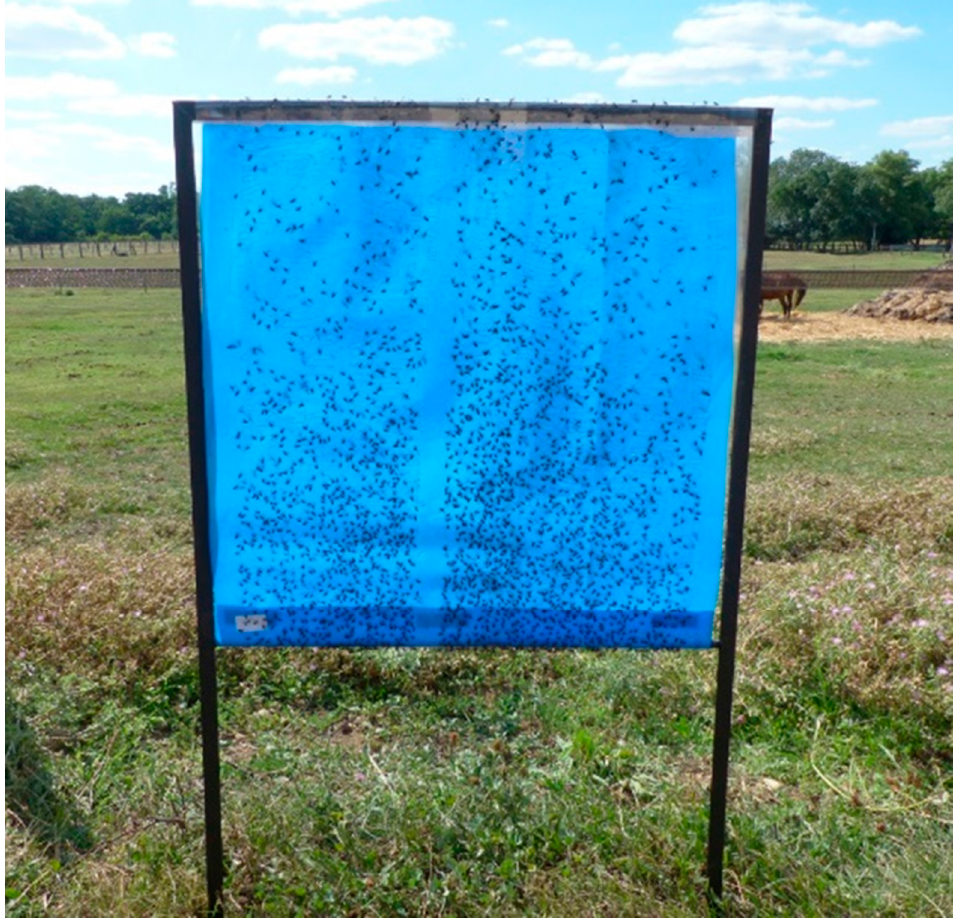
Figure 2. Metal frame and blue screen; the picture was taken at 16: 30 p.m. i.e., 8 h after the blue screen installation. At the back side: horse and manure.